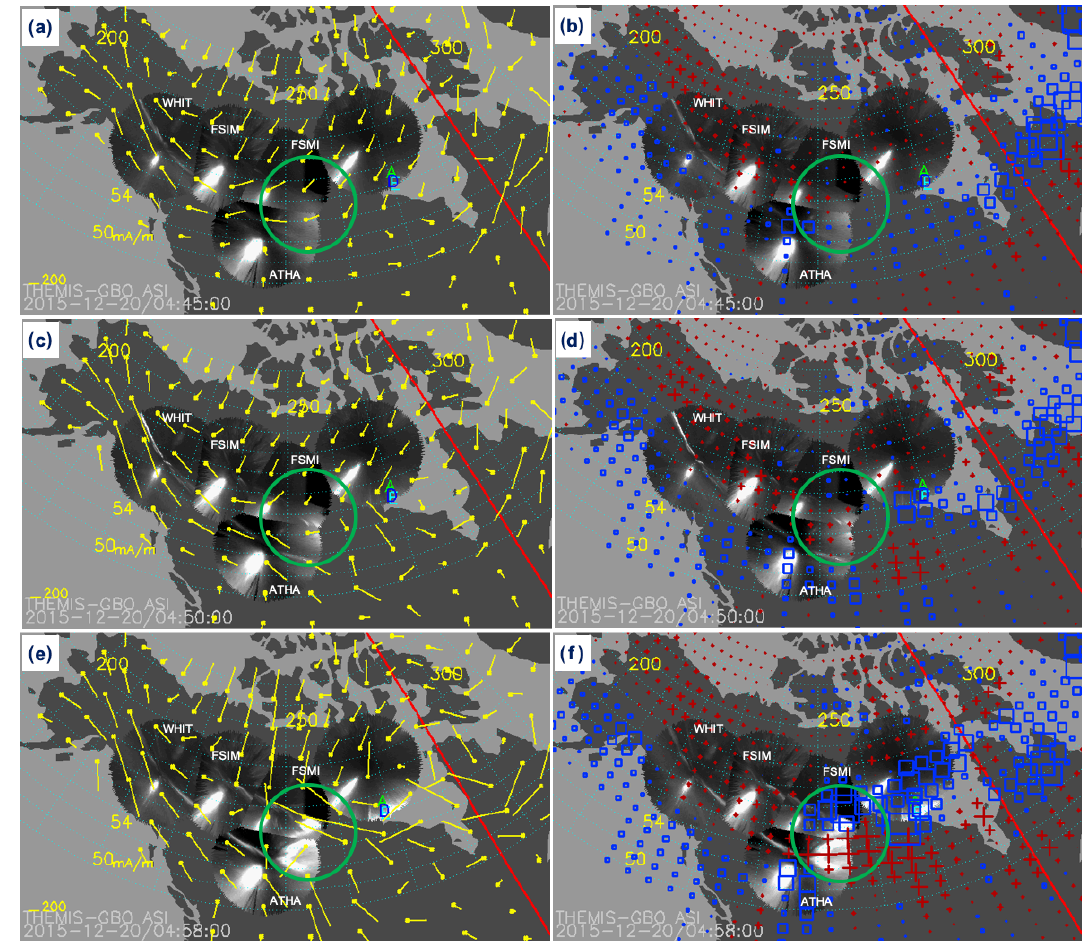
Figure 5. The derived equivalent ionospheric currents and current amplitudes plotted over a sequence of ASI mosaics for fast flow burst Case 4 on 20 December 2015. The yellow arrows represent the direction and the strength of the horizontal currents. The blue squares and the red plus signs show the current amplitudes. The red lines mark the midnight local time. The footprints of the three THEMIS satellites at an altitude of 110km are marked by letters A (THEMIS A), D (THEMIS D), and E (THEMIS E). Each ASI field of view is approximately 800km when mapped to a 110km altitude. The green circles mark the area of discussion. The snapshots show measurements (a,b) before, (c,d) during, and (e,f) after the fast flow